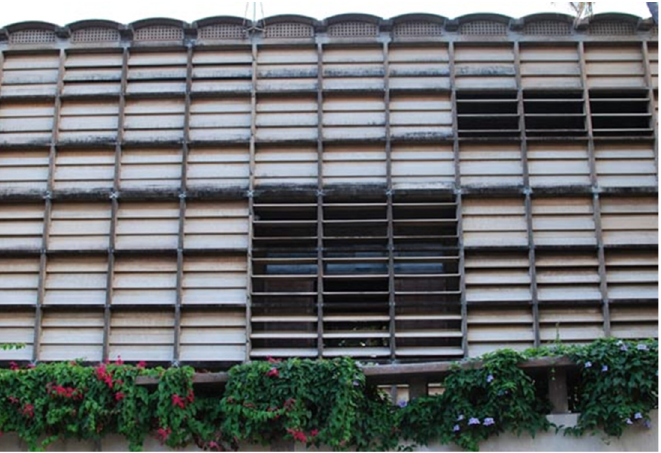
Figure 7. View from the south of the sleeping quarters in the Ashram of Sri Aurobindo. Pondicherry, India. An example of the external louvers.